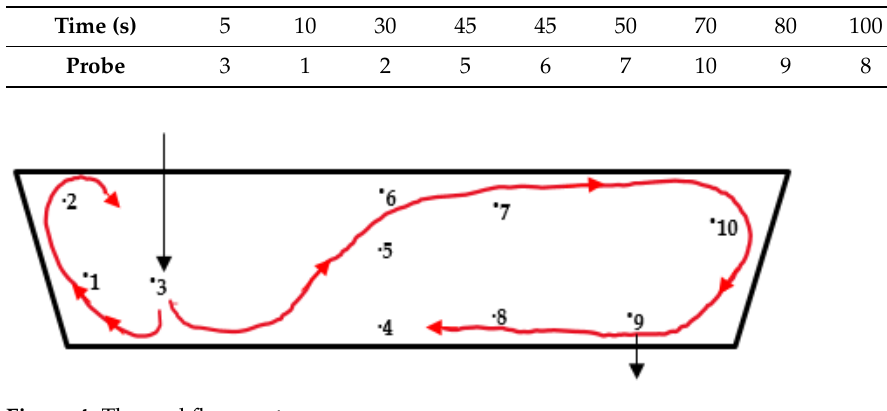
Figure 4. Thermal flow routes.